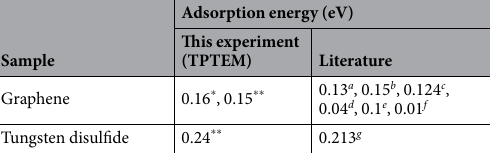
Table 1. Measured adsorption energy for physisorbed O 2 on graphene and tungsten disulfide using temperature-programmed THz emission microscope. * Chemical vapor deposition-grown sample. ** Liquid phase exfoliated sample. a O 2 molecule physisorbed on undoped graphene, obtained by first-principles calculations 19 . b O 2 molecule physisorbed on pristine graphene, obtained by first-principles calculations 20 . c (12.0 kJ/mol) O 2 molecule physisorbed on highly oriented pyrolytic graphite, obtained by thermal-desorption spectroscopy 24–26 . d O 2 molecule physisorbed on single layer graphite, obtained by density-functional calculations 17 . e,f O 2 molecule physisorbed on graphene, obtained by spin-unrestricted density-functional by first-principles calculations 22